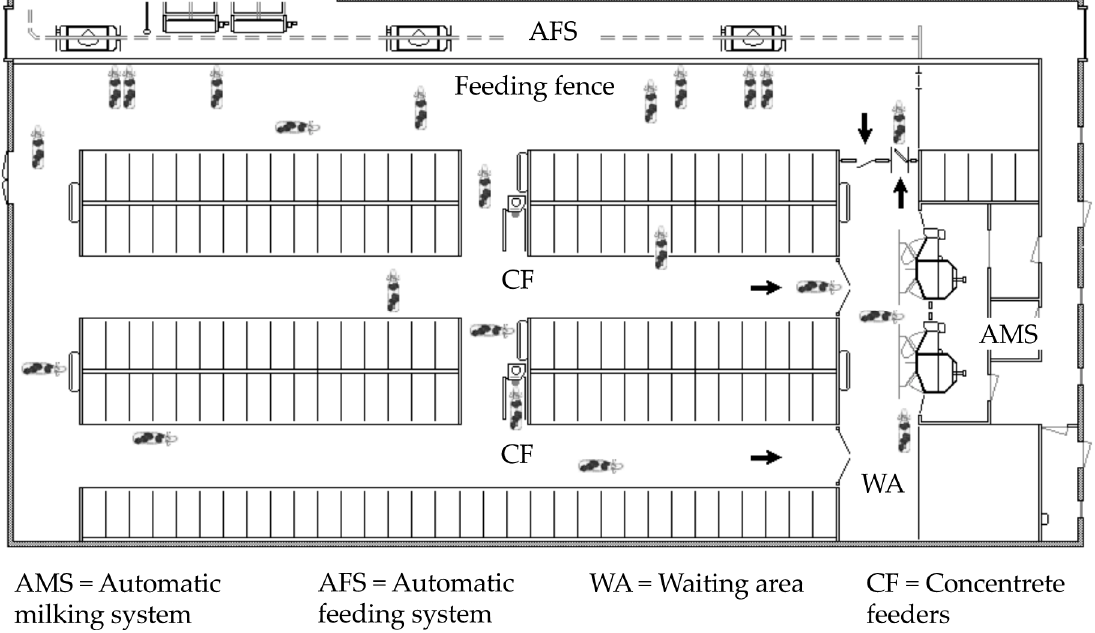
Figure 1. Barn layout with the position of the milking area composed by two automatic milking system units, automatic feeding system, and two automatic concentrate feeders.